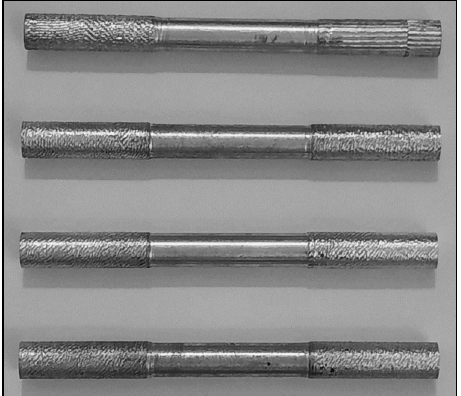
Figure 5. Casted samples machined into the tensile test specimen.